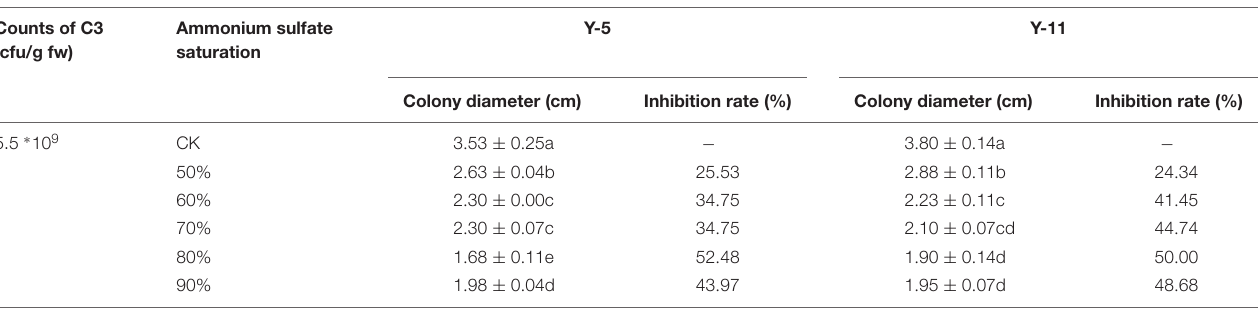
FIGURE 5 | Effect of C3 on the cell integrity and DNA Concentration of Pathogenic fungi ( A–d : pathogenic fungal hyphae stained with PI; E–h : pathogenic fungal hyphae stained with Hoechst 33258. A–b , E–f : hyphae of funguY-5; C–d , G–h : hyphae of funguY-11. The two columns on the left are the fungal hyphae of the control group, and the two columns on the right are the fungal hyphae co-cultured with C3). TABLE 2 | Inhibition of Pathogenic fungi by different saturation antibacterial